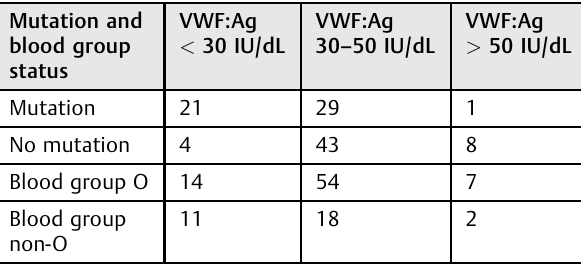
Table 4 VWF:Ag levels among Type 1 VWD patients